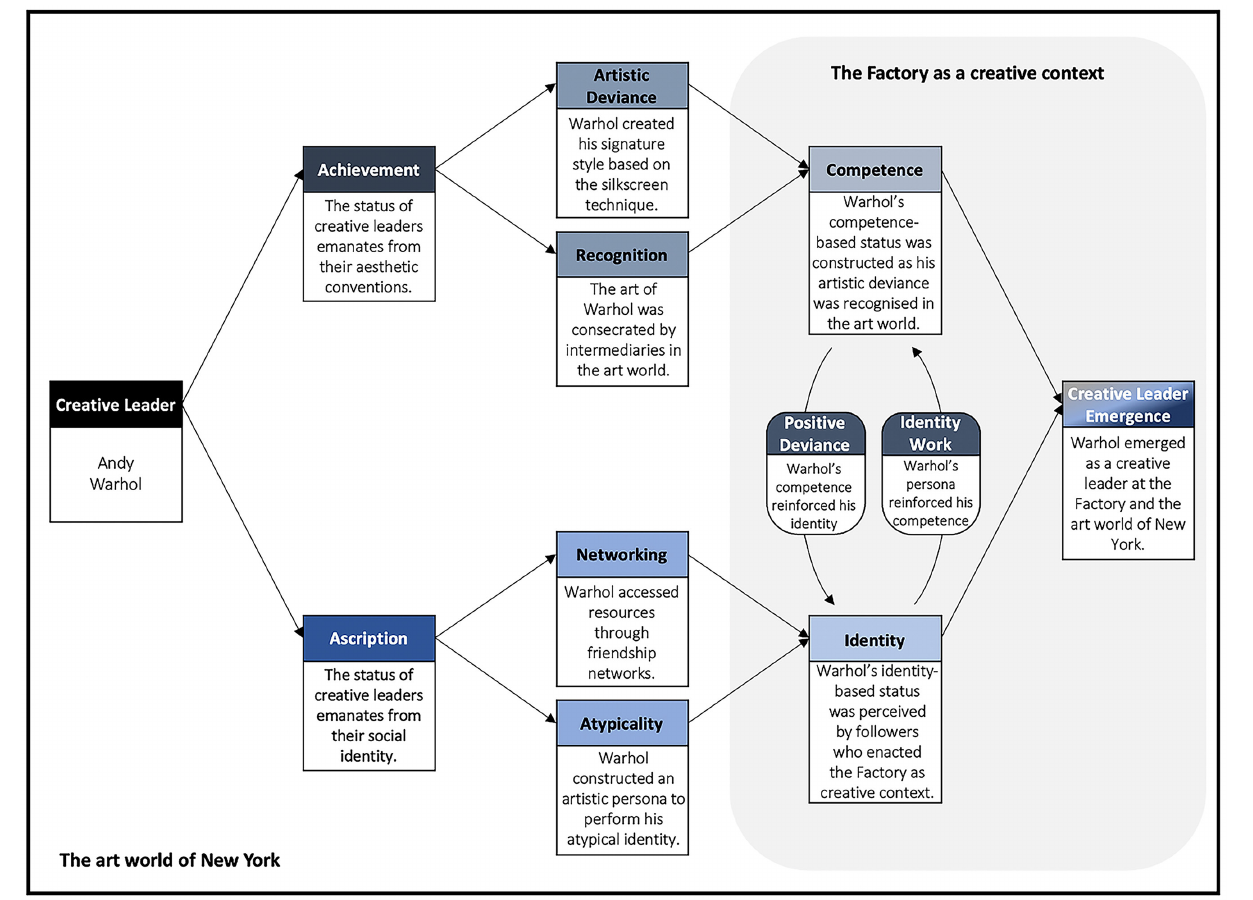
FIGURE 4 | The emergence of a creative leader within the art world illustrated by the case of Andy Warhol. Source: The authors.